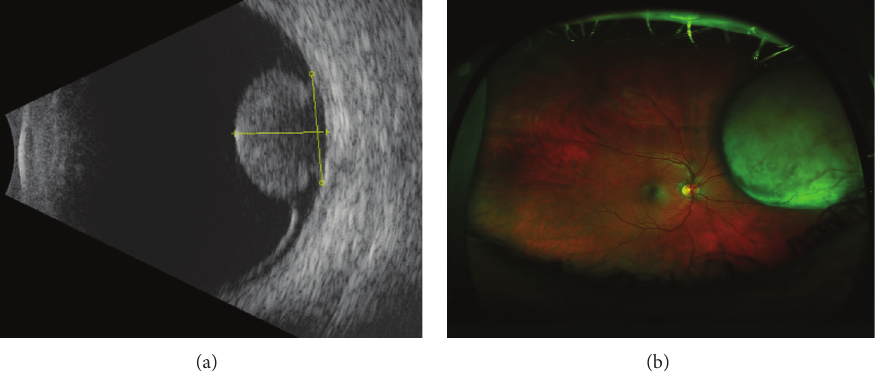
Figure 1: Appearance of the nasal choroidal melanoma (a) and B-scan ultrasonography with some vascularity and low reflectivity but no extrascleral extension (b).